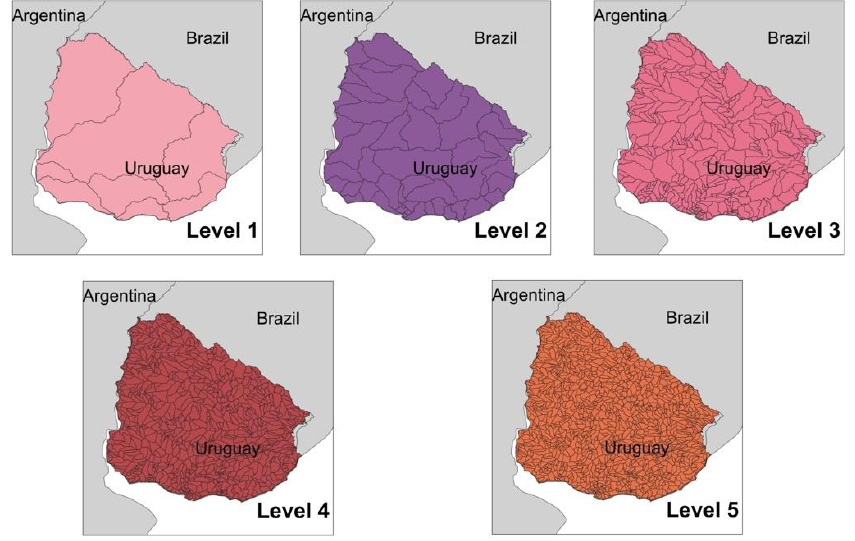
Figure 8. Uruguayan hydrographic basins in five levels of detail .